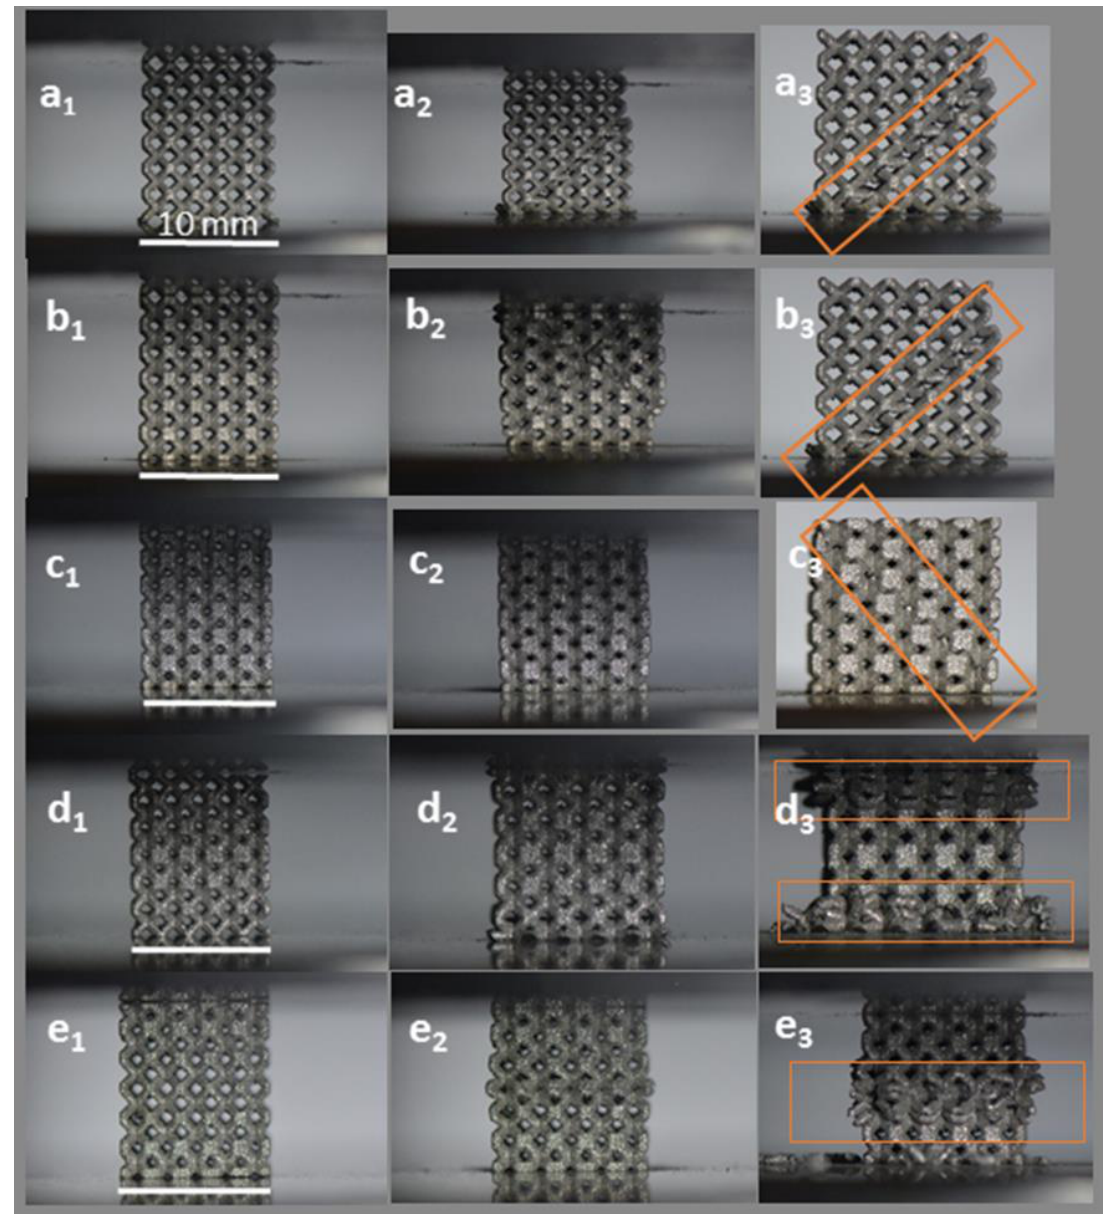
Figure 5. Failure modes of ( a ) U0.4, ( b ) U0.6, ( c ) U0.8, ( d ) Dense-In, ( e ) Dense-Out structures. Left images (subscript 1) represent the initial state and middle (subscript 2) and last right images (subscript 3) present the progressive failure. Highlights represent the observed regions of deformation and failure. (Scale bars = 10 mm).